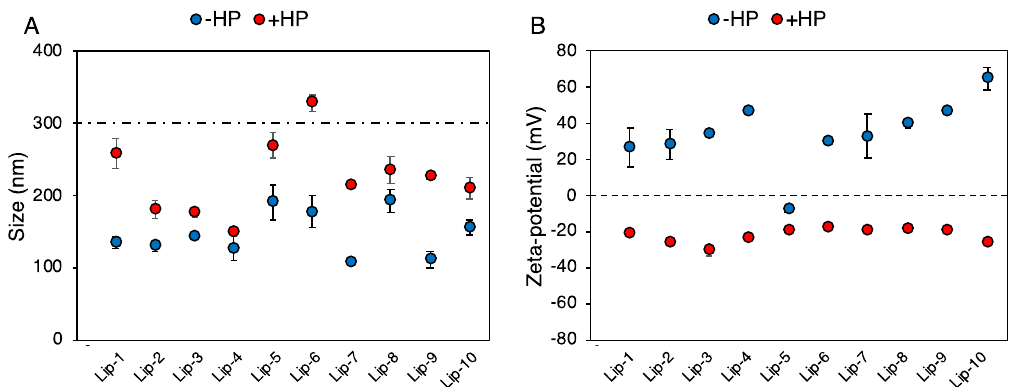
Figure 2. ( A ) Hydrodynamic diameter of liposomes before (blue points, “− human plasma (HP)”) and after (red points, “+ HP”) 1-h incubation with human plasma (HP) of pancreatic cancer patients. Values are means ± standard deviation from three independent experiments. The dashed line indicates a typical size threshold for particle removal from bloodstream by macrophages. ( B ) Zeta-potential of liposomes before (blue points, “− HP”) and after (red points, “+ HP”) 1-h incubation with human plasma (HP) of pancreatic cancer patients. Table 2. Polydispersity index (PDI) of bare liposomal formulations and after 1-h incubation with HP. Samples